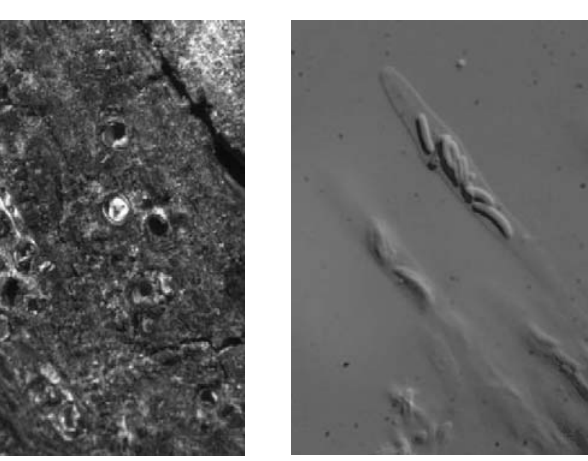
Fig. 2. Perithecia and ascospores of Eutypa lata collected in